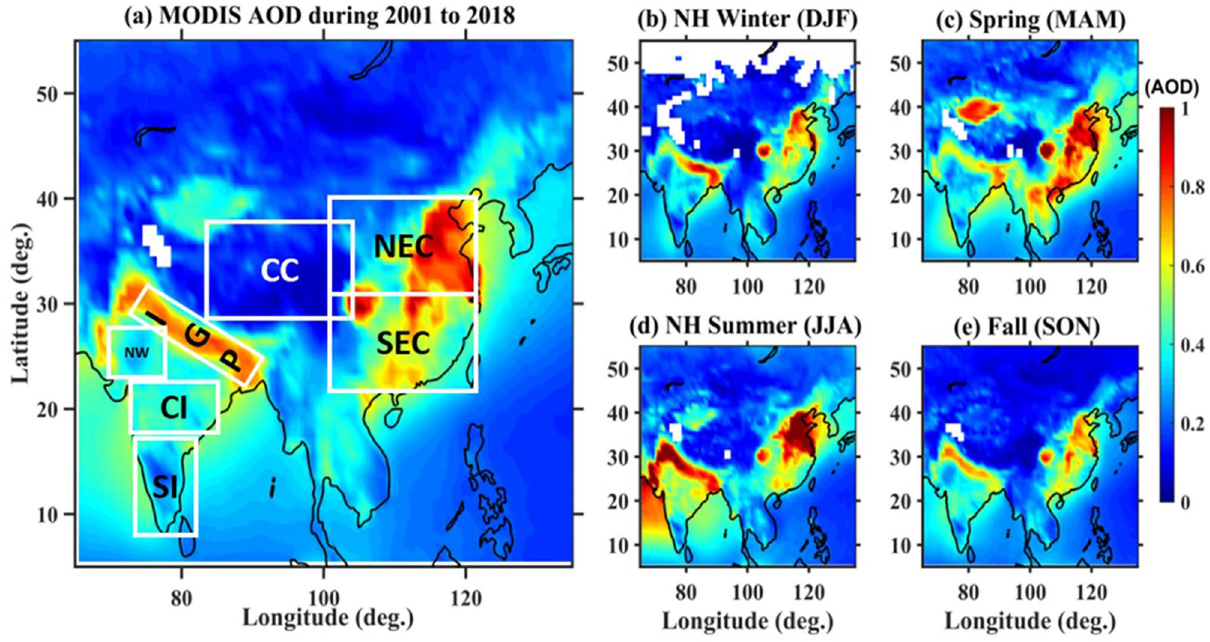
Figure 1. ( a ) Aerosol optical depth (AOD) climatology over South and East Asia observed using MODIS averaged during 2001–2018. Seasonal variation in AOD observed during ( b ) NH Winter (DJF), ( c ) Spring (MAM), ( d ) NH Summer (JJA) and ( e ) Fall (SON) seasons averaged during the same period. Different regions in ( a ) shown in the boxes represent south India (SI), central India (CI), northwest India (NW), Indo-Gangetic Plains (IGP), Central China (CC), northeast China (NEC) and southeast China (SEC). The maps were created by using MATLAB software R2019b with mapping tool box (see https ://in.mathw orks.com/produ cts/new_ produ cts/relea se201 9b.html and https ://www.mathw orks.com/produ cts/mappi